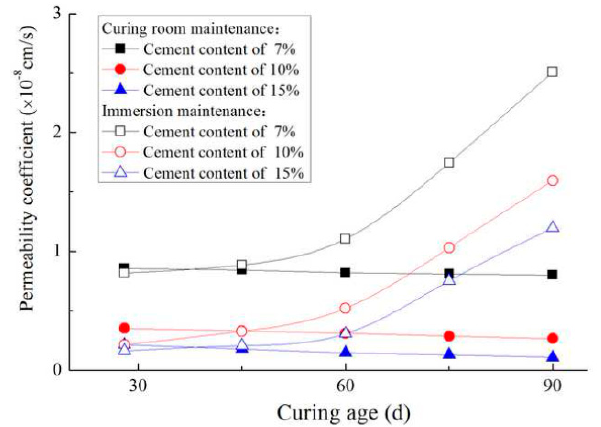
Figure 10. Variation curves of permeability coefficients with curing age.